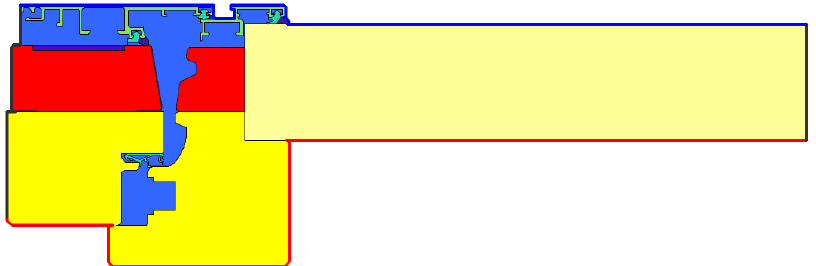
Figure 2. Cross section of the frame, as designed in the finite element method software Flixo, used for the simulation. In this case, each color represents a material, modeled with di ff erent thermal properties. The yellow section on the left represents soft wood; the light yellow area represents the replacement panel with given thermal resistance, replacing the triple glass in the numerical analysis; the aerogel is colored in red; and the aluminium is in light green. A di ff erent shade of green was used for EPDM and light blue for air within the frame.